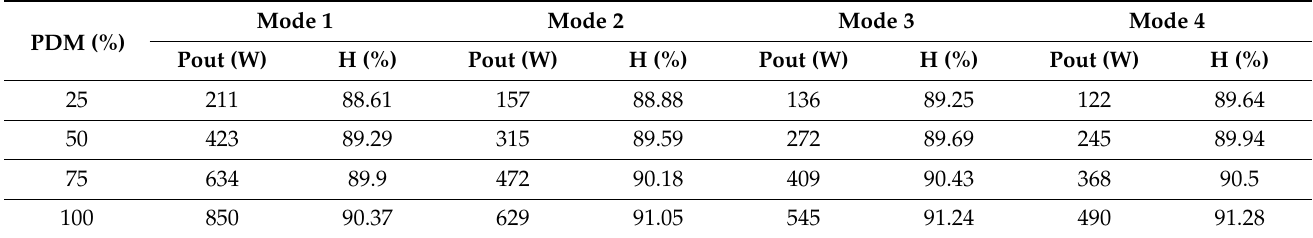
ferent PDM ranges. different PDM ranges. Table 2. Efficiency for various modes at different PDMs. Table 2. Efficiency for various modes at different